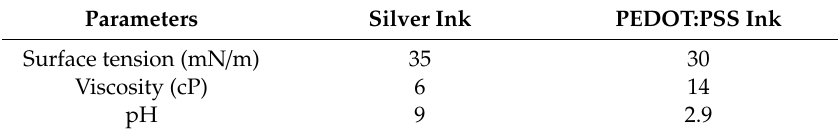
Table 1. Measured parameters of the Ag and PEDOT:PSS inks. Parameters Silver Ink PEDOT:PSS Ink